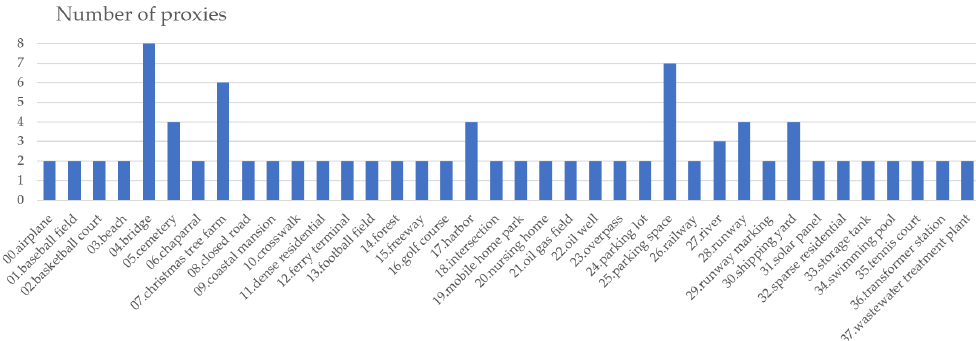
Figure 12. The number of proxies assigned to each class in the PatternNet dataset by our proposed adaptive multi-proxy assignment method.